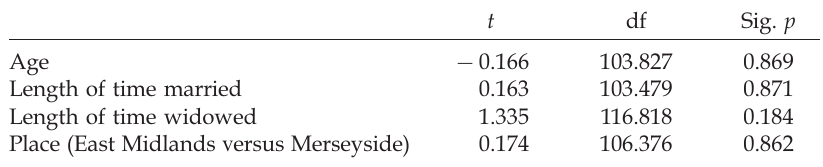
Table 2. T -test to show non-significant differences between sub-groups of lonely and those not spontaneously reporting loneliness